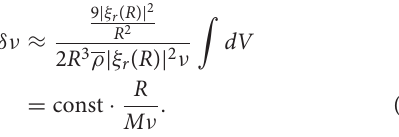
FIGURE 2 | Frequency shift amplitudes for full activity cycles for the synthetic TESS sample calculated with Equation (15). The color of the dots indicates stellar age. The Sun is indicated by its usual